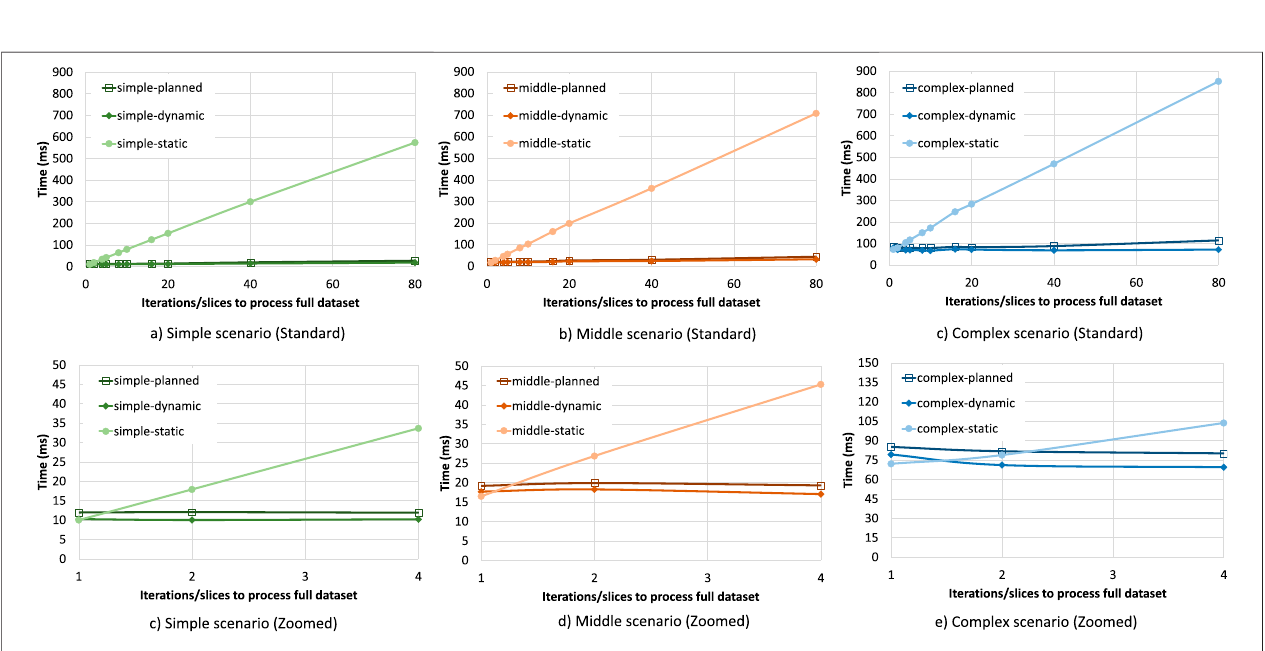
FIGURE 9 | Overview of the restarting experiment, with the start and stop symbols representing the recon fi guration of the pipelines.